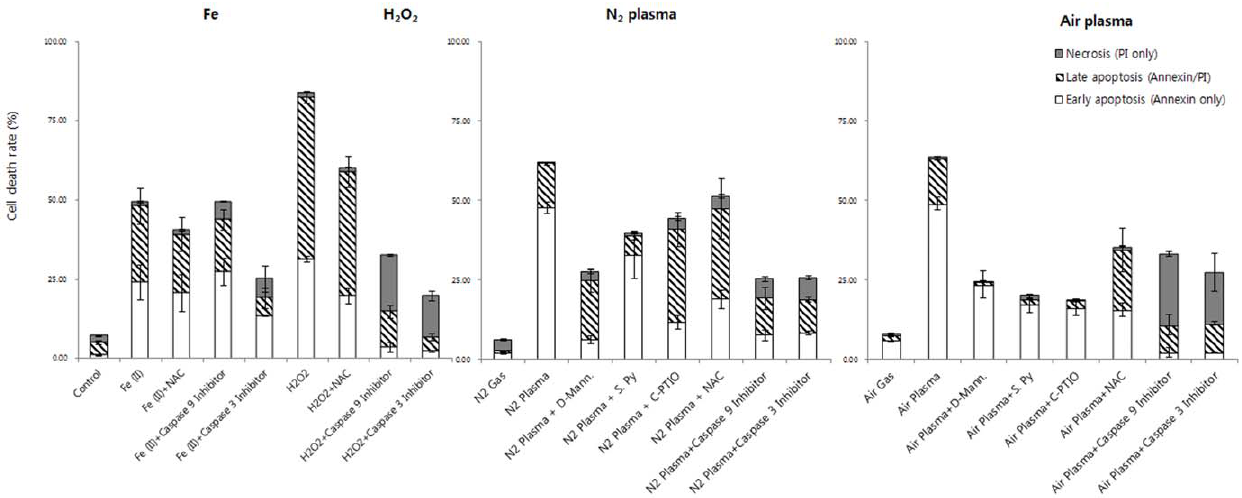
Figure 5. Scavenging agents are able to alleviate the apoptotic effect induced by N 2 and air plasma exposure in HeLa cells. Cells were treated with D-Mannitol, sodium pyruvate, carboxyl-PTIO or N-Acetyl-cystein (NAC) for 1 hr prior to treatment with an air and N 2 plasma jet. HeLa cells were exposed to the air and N 2 plasma jet, immediately after treatment with caspase 3 or 9 inhibitor. Data are shown as the mean 6 s.e.m. ( n =10). Values were shown in Fig